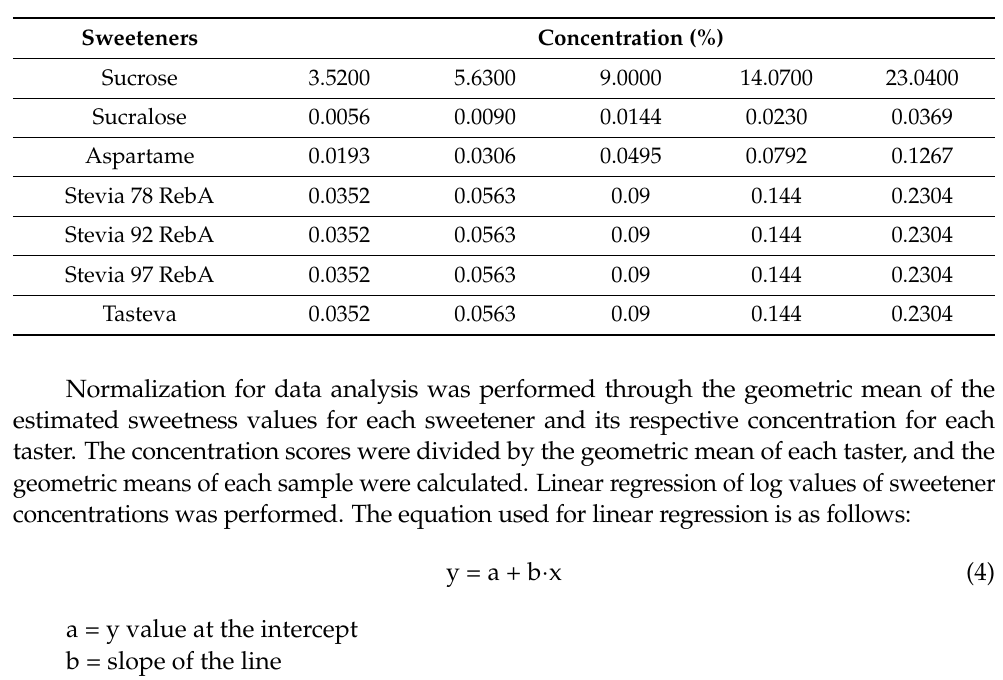
Table 1. Sweeteners concentration to determine sweetness